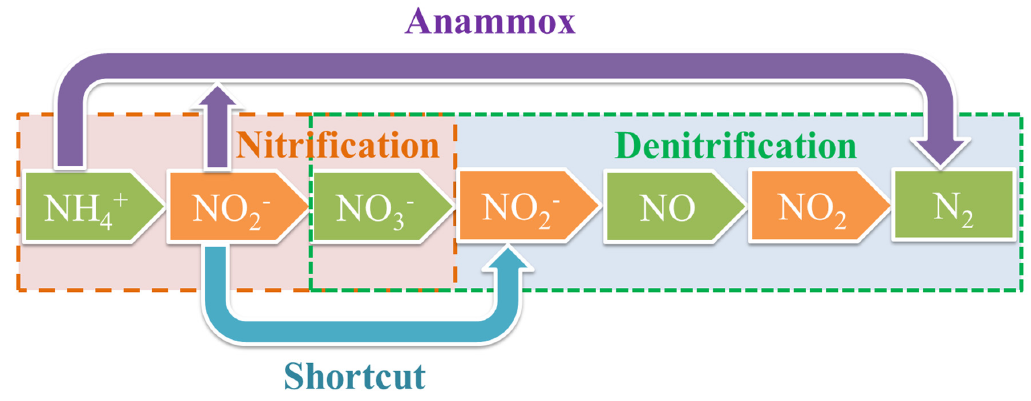
Figure 1. Flow chart of the traditional biological process for removal of nitrogenous compounds.